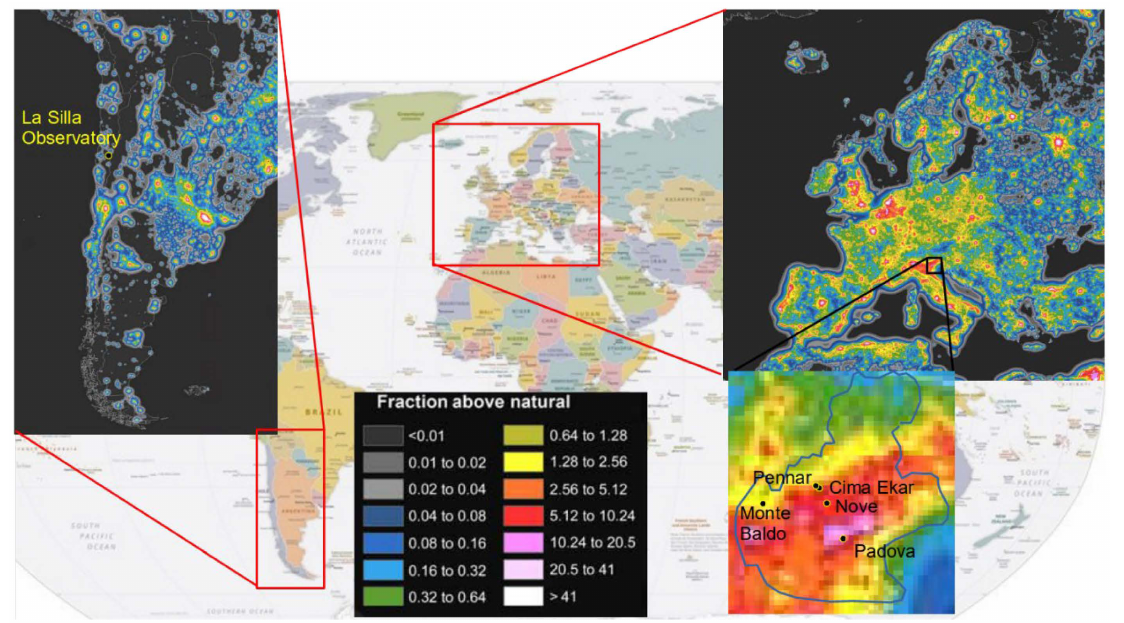
Figure 1. Location of the stations analysed in this work. The image is obtained processing data from